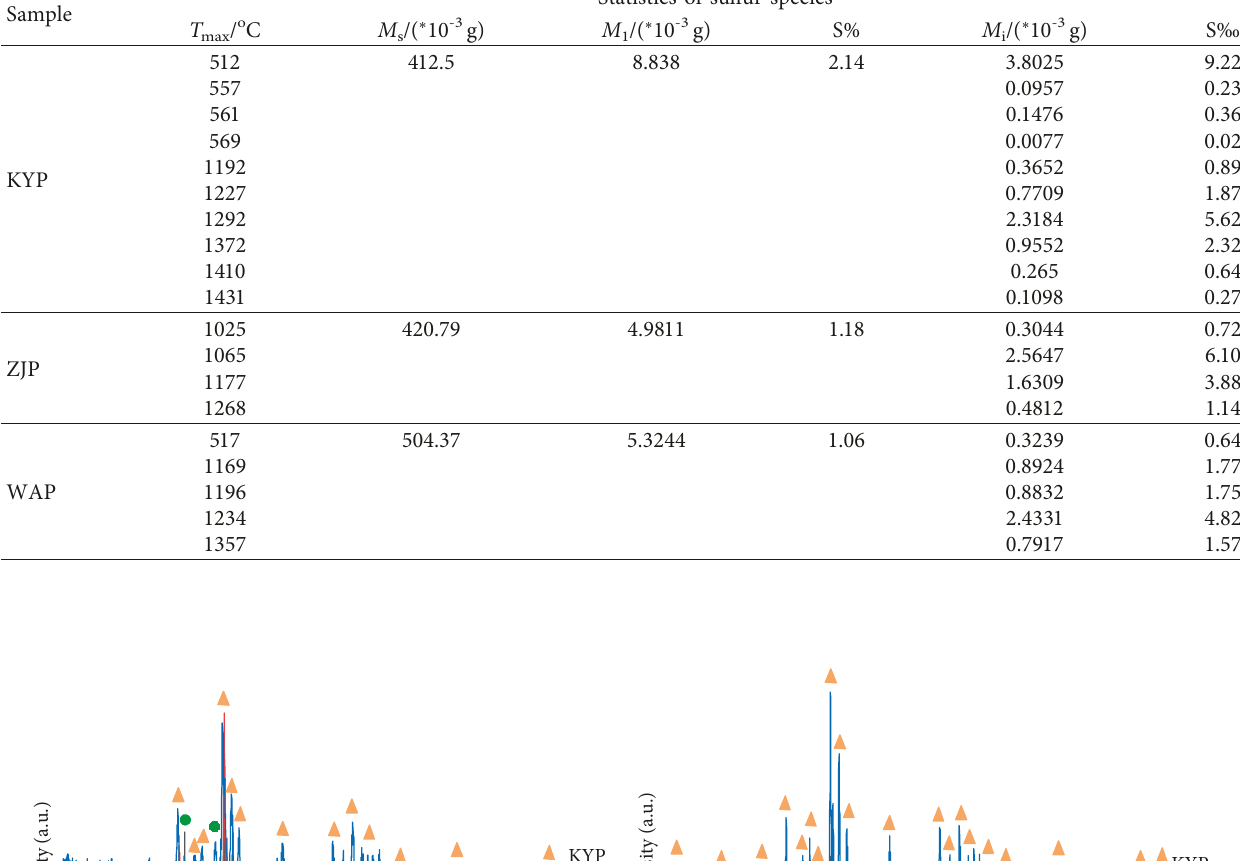
Table 3: Statistics of sulfur species of phosphate rock samples.